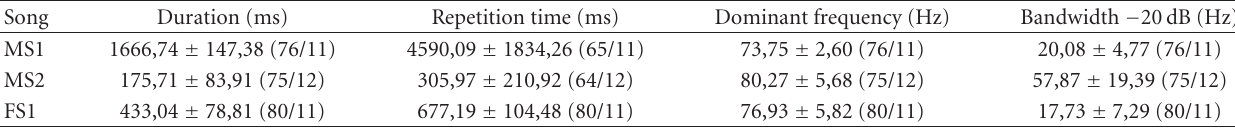
Table 3: Temporal and spectral characteristics of male and female songs of Edessa meditabunda. Mean ± SD are show with the number of signals test ( N ) and the number of insect tested ( n